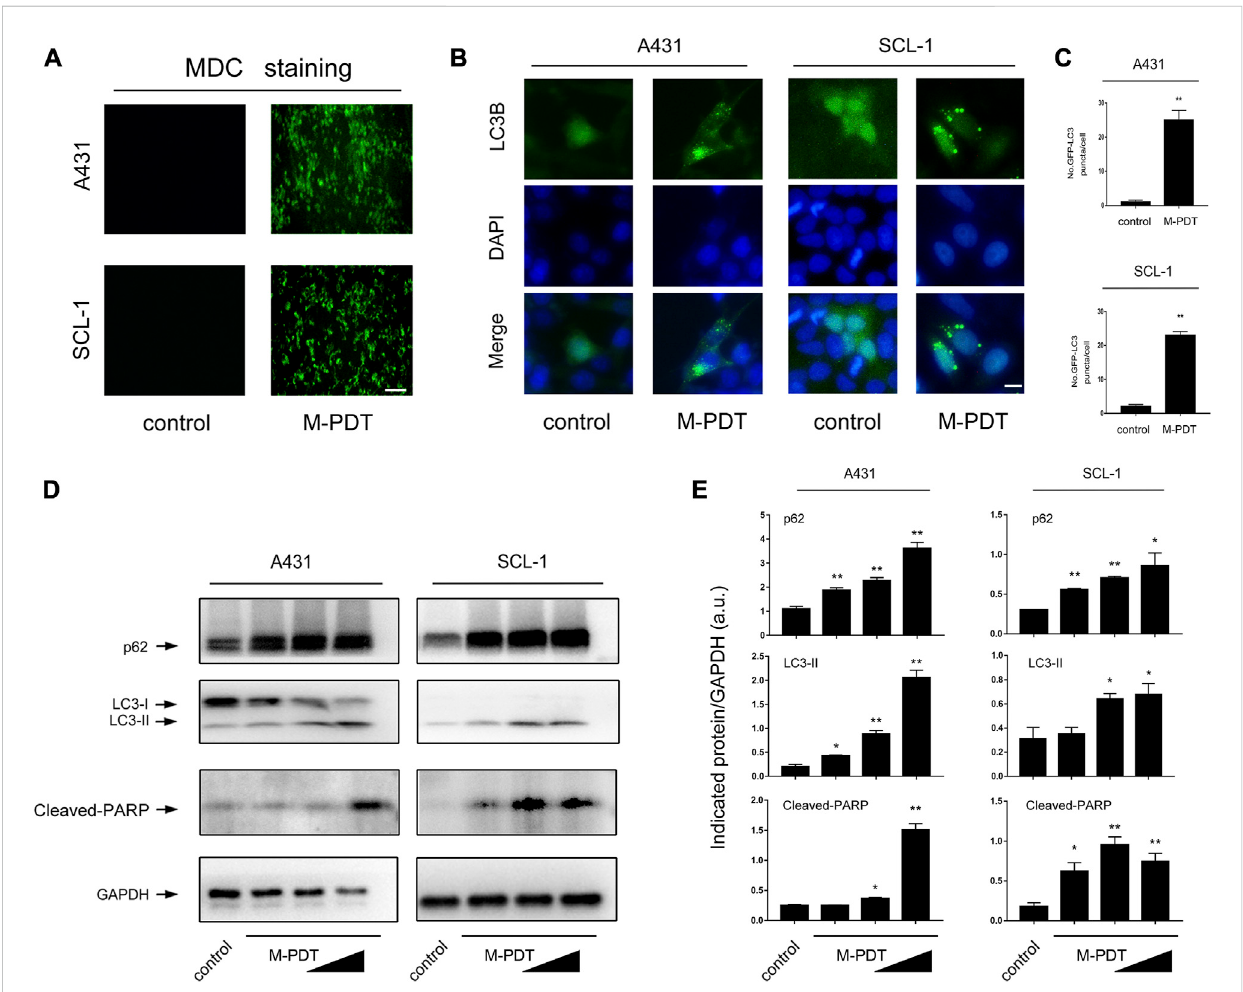
FIGURE 2 M-PDT induces autophagosomes accumulation and upregulation of LC3-II and p62 expression in cSCC cells (A) The cSCC cells were labeled using MDCstaining,thescalebaris100 μ m. (B,C) RepresentativeGFP-LC3B fl uorescenceimages (B) andquanti fi ednumberforGFP-LC3Bpuncta (C) incSCC cells, the scale bar is 10 μ m. (D) Western blot for indicated antibodies. GAPDH is a loading control. Similar results were observed in three independent experiments. (E) The relative densities for LC3-II, p62, and Cleaved-PARP were semi-quanti fi ed. * p < 0.05, ** p < 0.01, difference vs. control group. n =